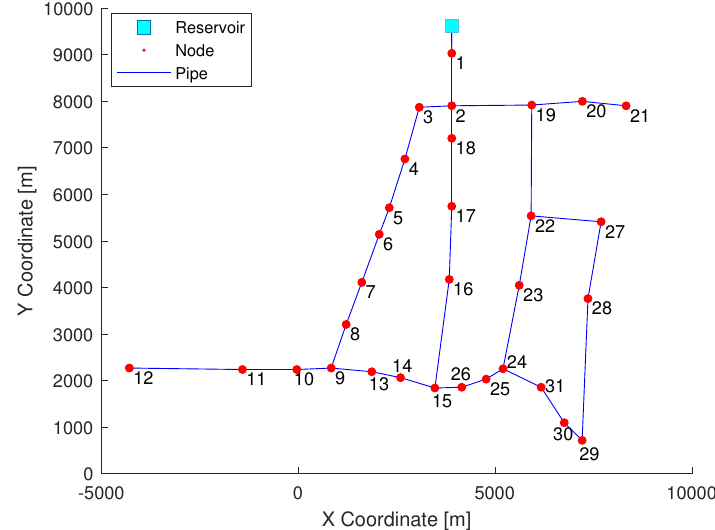
Figure 1. Simplified Hanoi topological